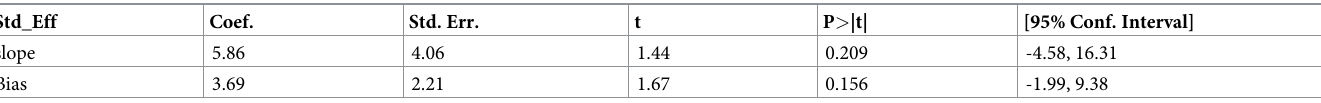
Subgroup analysis deployed publication year, regions, sample size, sampling method, and study period was used to find the cause of heterogeneity across the included studies. According to the results of the subgroup analysis, the pooled prevalence of UTI among HIV-positive peo- ple ranged from 10.7% in Amhara to 14.84% in Oromia. So the Oromia region had the highest pooled prevalence of UTI, followed by Addis Ababa with 12.78, and Amhara with the lowest pooled prevalence (Fig 3). Simple random sampling had the largest heterogeneity (OR:14, 95% Table 2. Checking publication bias using egger test. Std_Eff